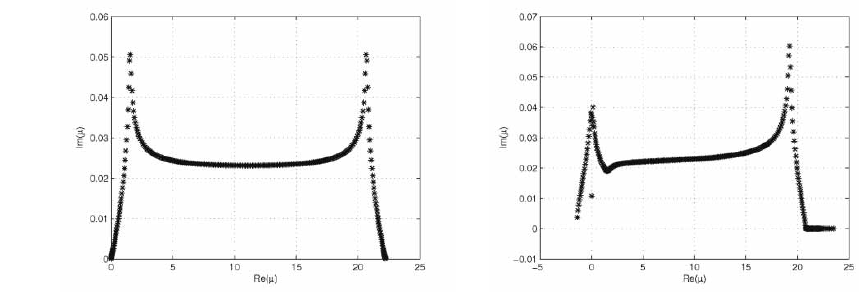
Figure 7. Discrete (new) eigenvalues in the plane (Re μ, Im μ ), N = 268, L = 113 . 7, γ = 1 . 1934982, I =